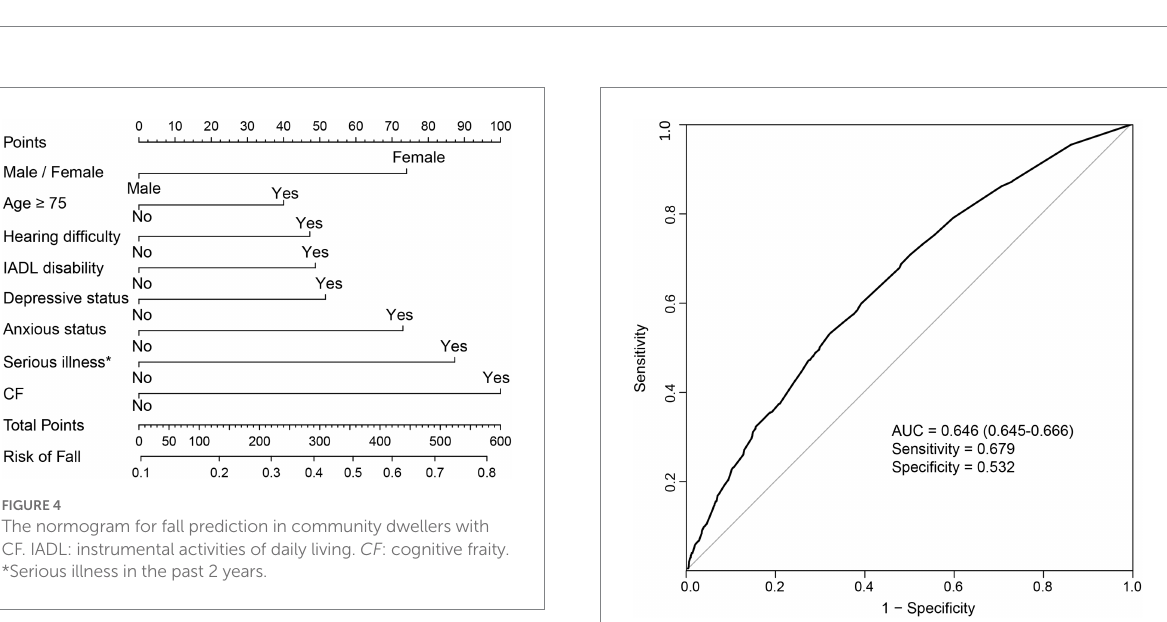
FIGURE 3 Forest plot for factors significantly associated with falls. IADL: instrumental activities of daily living. CF : cognitive fraity. OR: odds ratio. CI: confidence interval. *Serious illness in the past 2 years.